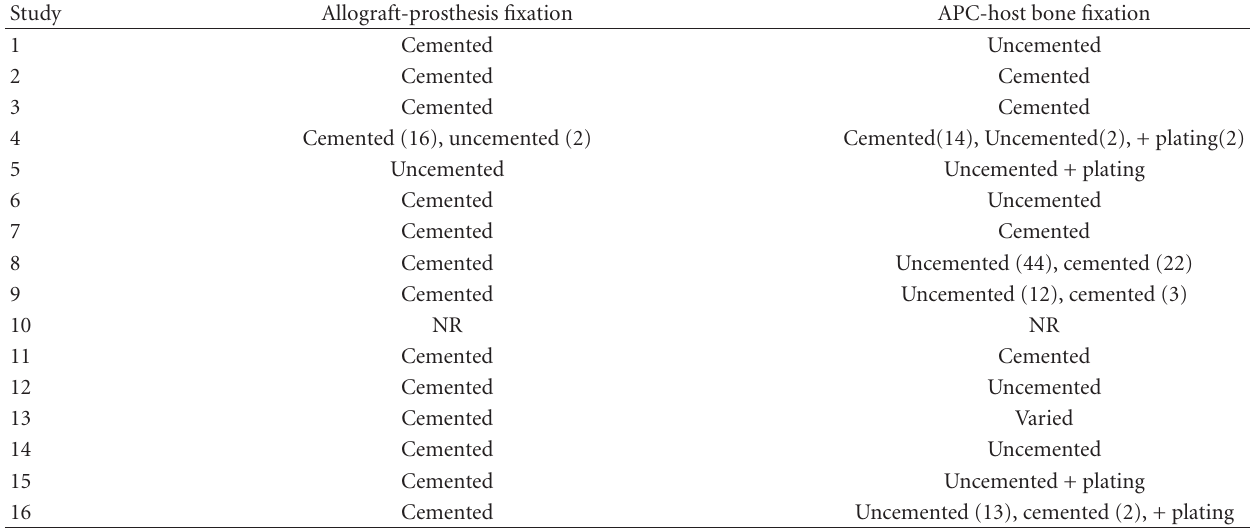
Table 3: Table showing methods of implantation of prosthesis into allograft to form the allograft prosthesis composite (APC) and methods for securing APC to distal host femur. NR: not reported. Study numbers correlate with Table 1.